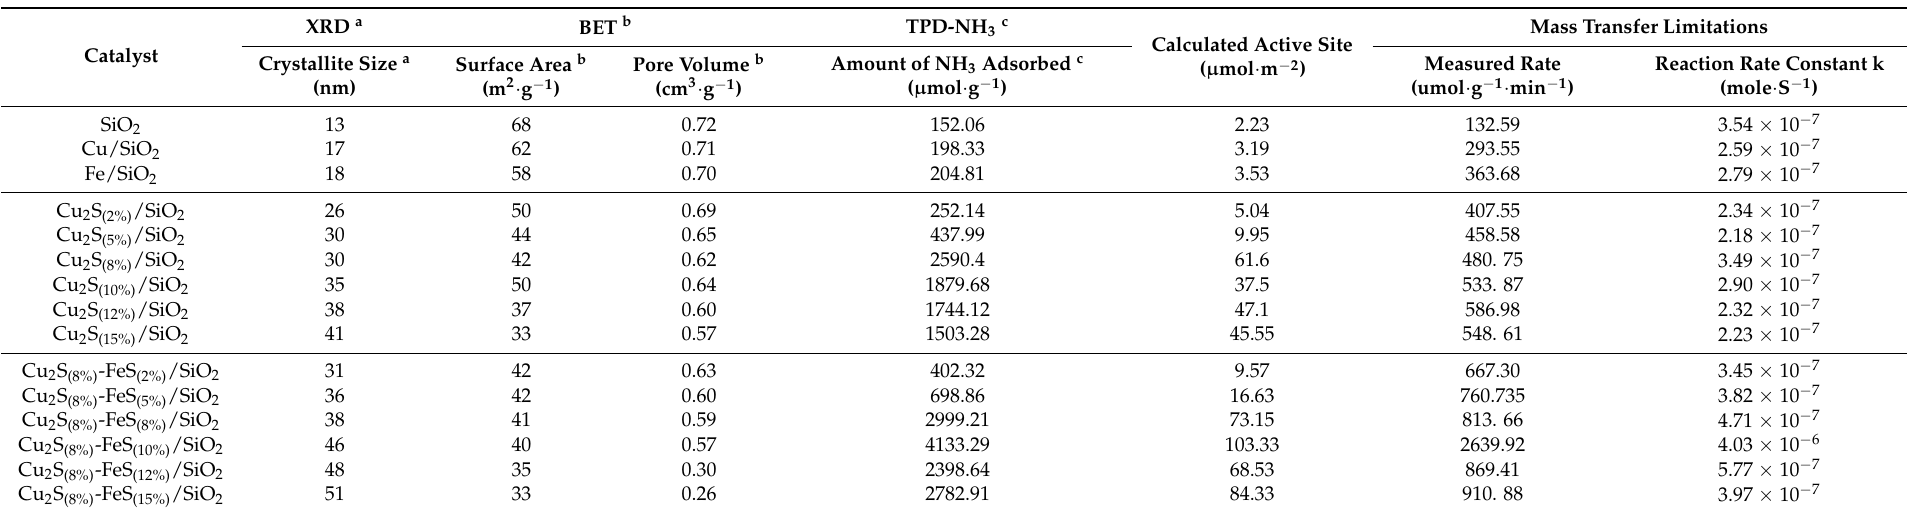
Table 1. Physicochemical properties of synthesised silica and monometallic